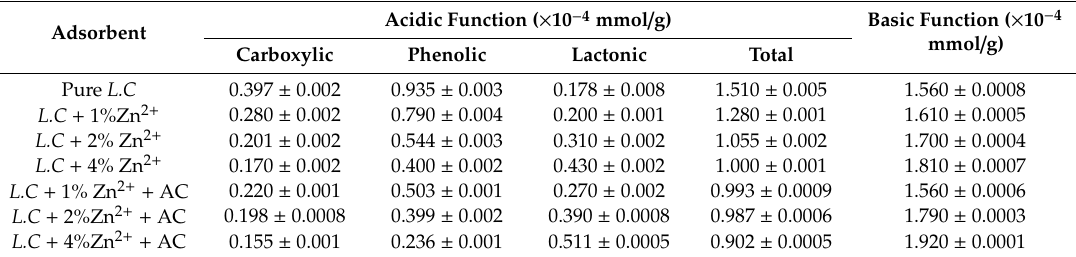
Table 3. Di ff erent functional groups obtained on the adsorbent